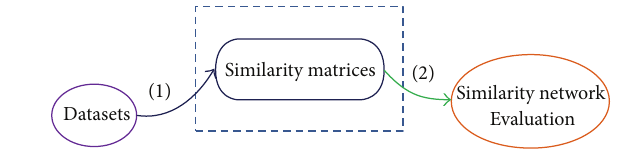
Figure 3: The computing steps of similarity networks